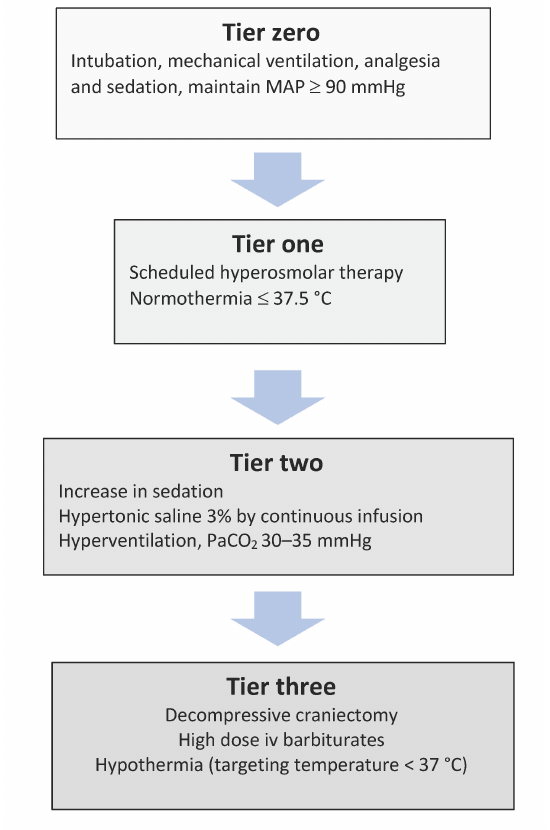
Figure 3. A simplified version of the three-tier therapy protocol proposed for the treatment of sus- pected intracranial hypertension when intracranial pressure monitoring is not employed. Decisions on escalation and de-escalation are based on serial clinical examination and computerized tomogra- phy imaging. MAP: mean arterial pressure; PaCO 2 : partial arterial pressure of carbon